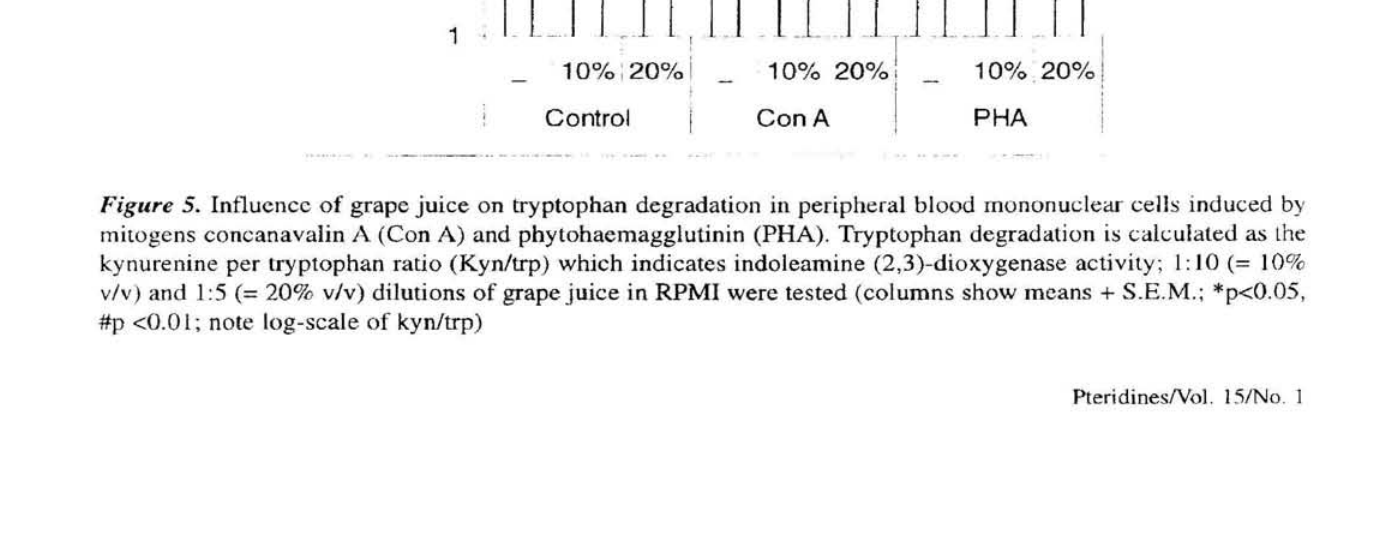
Pteridines/Vol. 15/No.